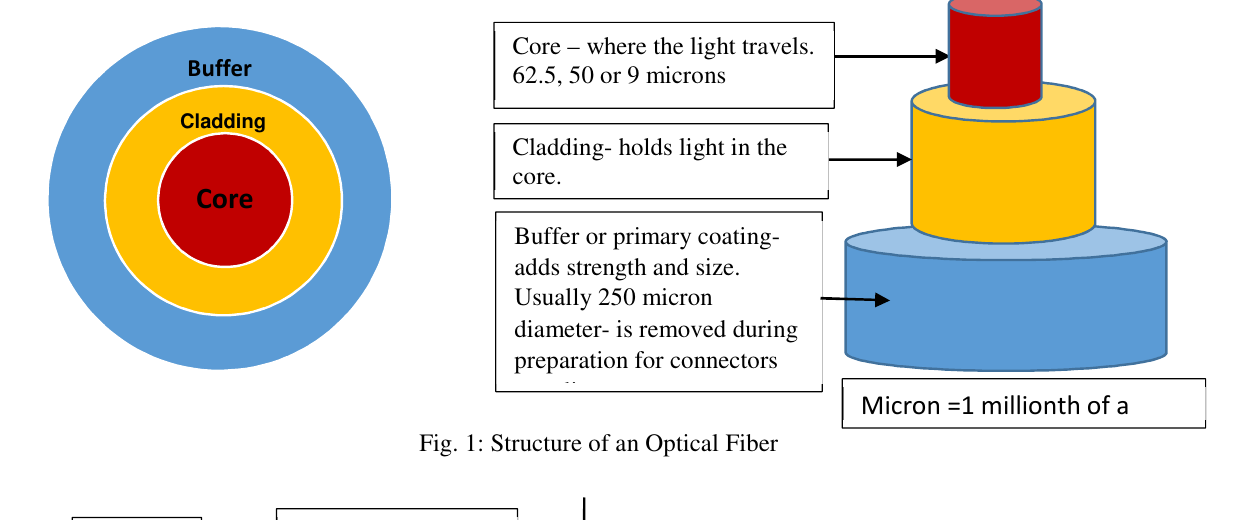
2.5 Translucent Concrete: How is it used? Featured in the “Liquid Stone” exhibit at the National Building Museum in 2006, translucent concrete not only opened peoples’ eyes to all kinds of possibilities, but has also prompted companies to experiment with and use the material to create their own products. While the material has definite architectural and interior design application, a few companies are working with light-transmitting concrete with exclusive practical applications. The translucent concrete was being used for interior decoration